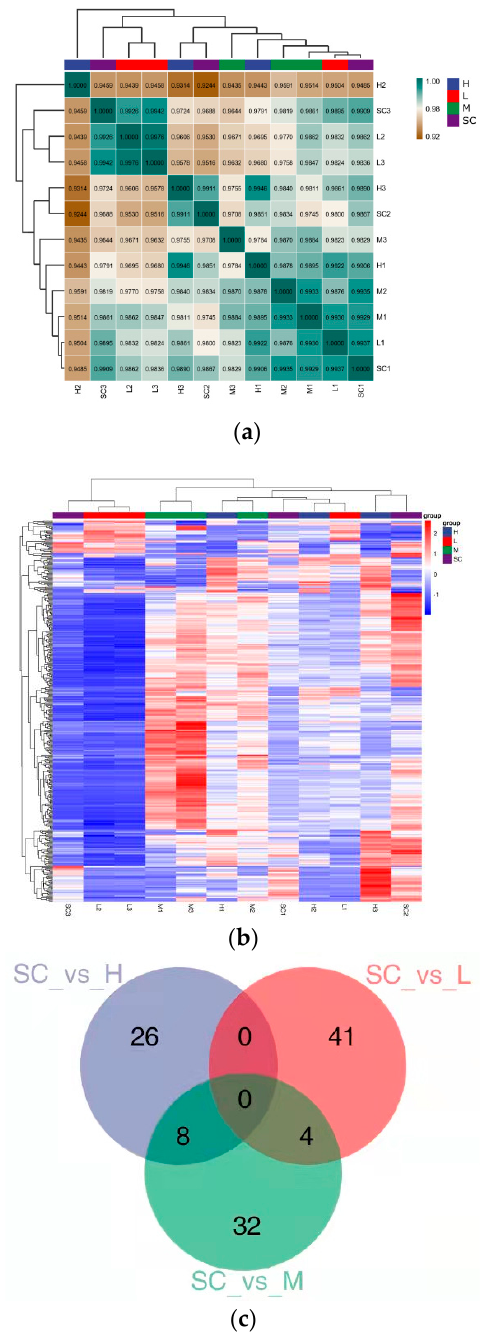
Figure 3. Transcriptomic profiles of D. magna after 9 d exposure to diethylstilbestrol (DES). ( a ) Correlation analysis of patterns of gene expression in solvent control groups and DES treatment groups; ( b ) a heatmap of centered and scaled FPKM value of DEGs in solvent control groups and DES treatment groups; ( c ) Venn diagram of the number of DEGs in each DES treatment group. SC: solvent control; L: low; M: medium; H: high. Table 1. KEGG pathways significantly enriched ( p < 0.05) in D. magna exposed to DES. Pathways Category Up-Genes SC vs. L